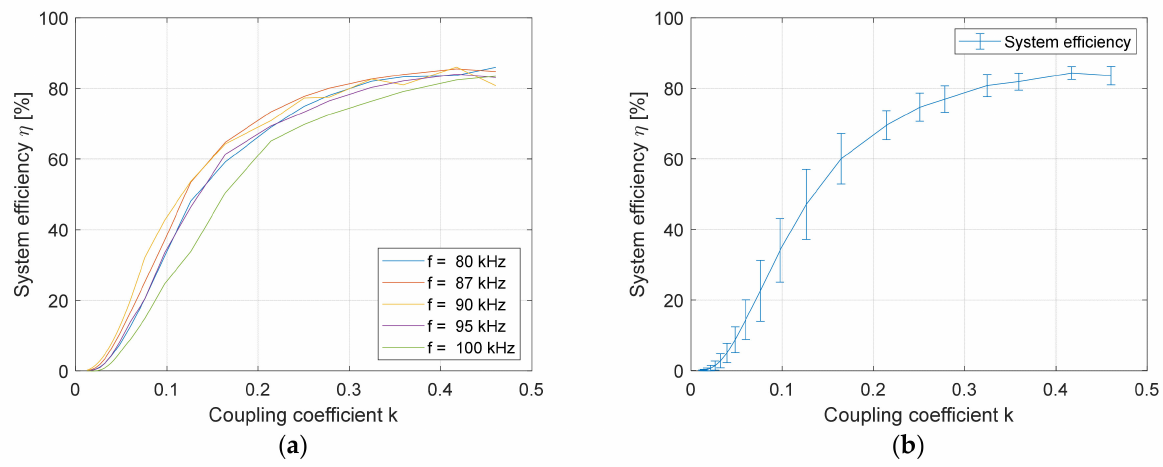
Figure 16. Efficiency of IPT using the single DD coil structure: ( a ) at different frequencies; ( b ) average system